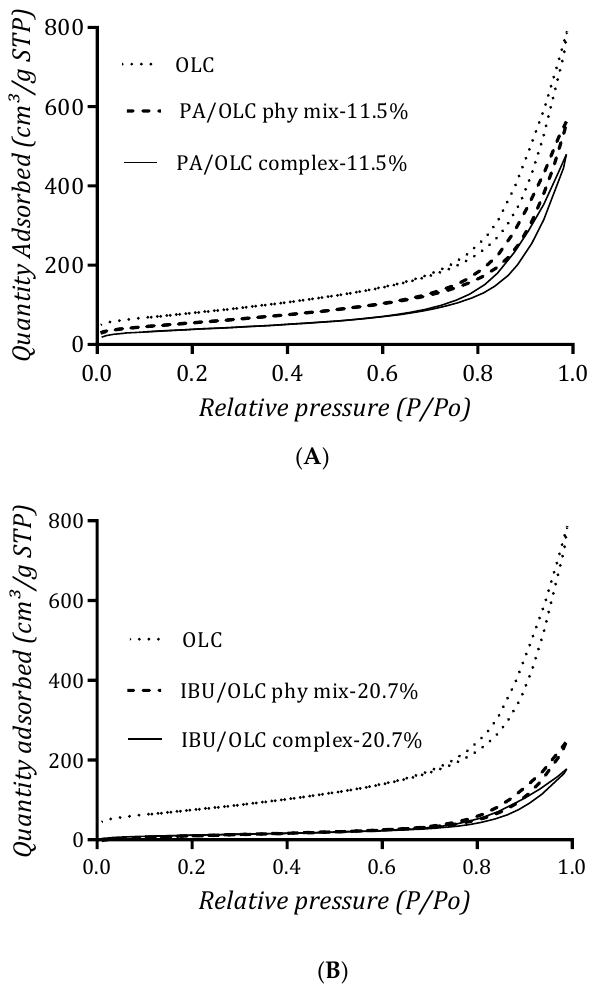
Figure 9. Nitrogen adsorption / desorption isotherms at 77 K of carbon onion (OLC) before and after drug loading showing, ( A ) paracetamol loaded carbon onion (PA / OLC complex) and physical mixture of paracetamol and carbon onion (PA / OLC phy mix); ( B ) ibuprofen-loaded carbon onion (IBU / OLC complex) and physical mixture of ibuprofen and carbon onion (IBU / OLC phy